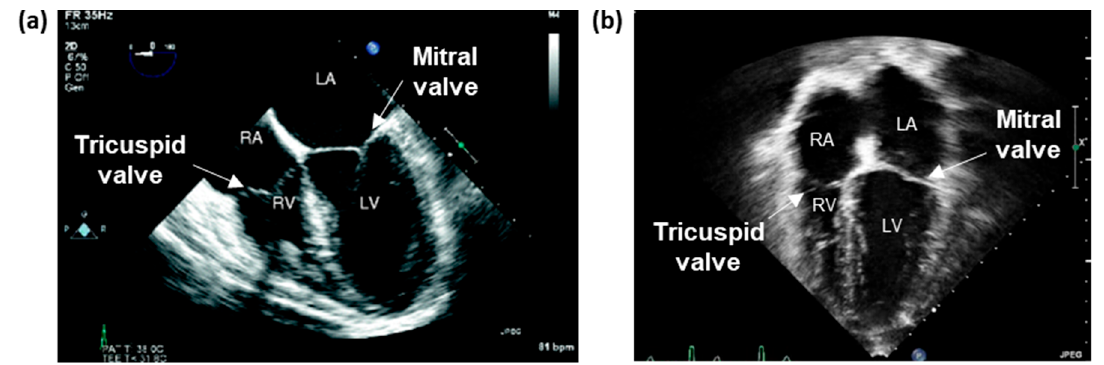
Figure 4. Echocardiographic imaging modalities: ( a ) a four-chamber mid-esophageal view using TEE (image modified from [58]), and ( b ) an apical four-chamber view (A4C) using TTE courtesy of Dr. Mir and Dr. Burkhart from the Children’s Heart Center at the University of Oklahoma Health Sciences Center (OUHSC).